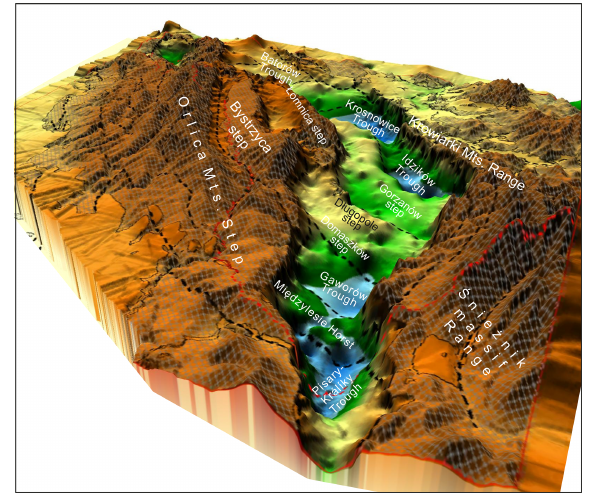
Figure 15. Perspective view towards the north onto the base Cre- taceous relief (known from boreholes) in the Upper Nysa–Králiky Graben (from Badura and Rauch, 2014). The oblique-striking troughs, steps and horsts reflect NW–SE-trending Late Cretaceous– early Palaeogene structural grain defined by inverted blocks under- lying the Cretaceous graben floor and folds in its fill (removed from the picture), once continuing laterally, before the graben formation in Miocene times. Location given in Fig. 2.